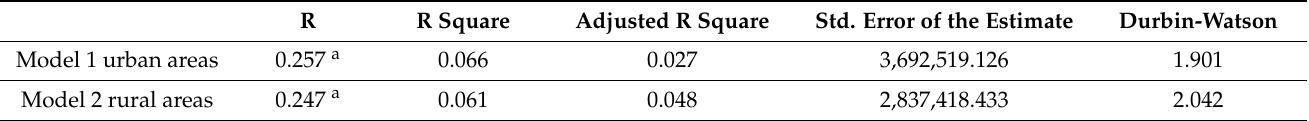
Table 8. Model 1 and model 2 summary a,b .